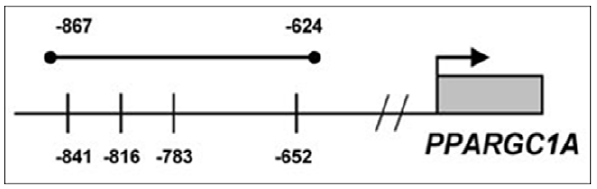
Figure 1. CpG sites analyzed in the PPARGC1A promoter. The CpG sites investigated are marked with a perpendicular